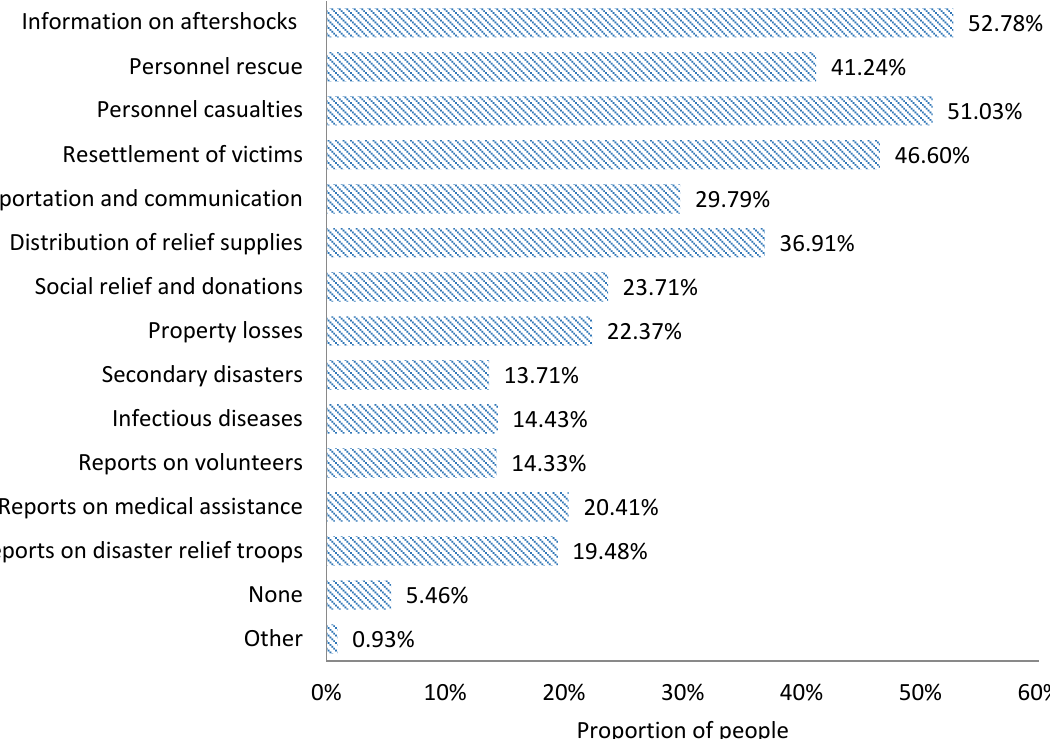
Figure 6. Information expected to be acquired by the public in the chronic stage of an earthquake disaster.